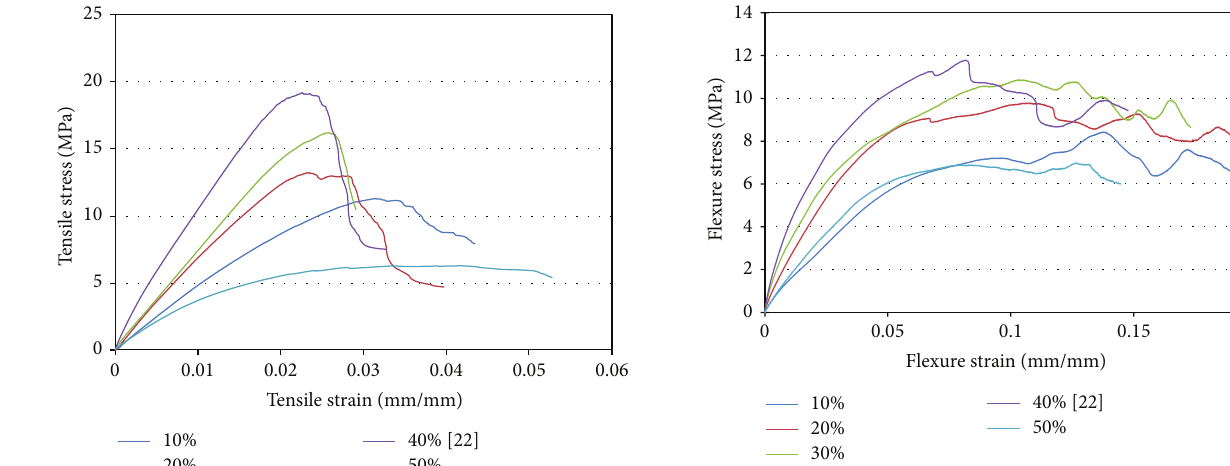
Figure 4: Effect of different kenaf fiber content on flexural proper- ties of kenaf/PVB